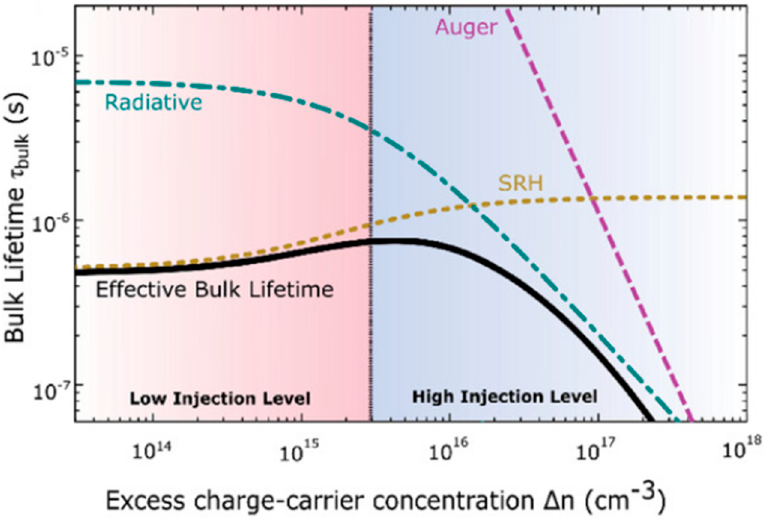
Figure 3. Relation between the charge carrier concentration, ∆ n, and the different contributions to charge recombination. At low charge densities the effective bulk lifetime is mainly determined by the Shockley–Read–Hall (SRH) recombination. At higher levels, radiative charge recombination determines the bulk lifetime for p-type MAPbI 3 . Reproduced with permission from Adv. Mater. 2019 , 31 , 1900428 . Reference [3].